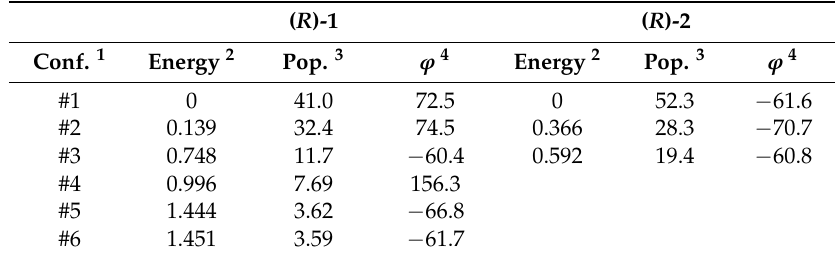
Table 1. Low-energy conformers of compounds ( R )- 1 and ( R )- 2 calculated at ω B97X-D/def2-TZVP/PCM level with relative energies and populations.